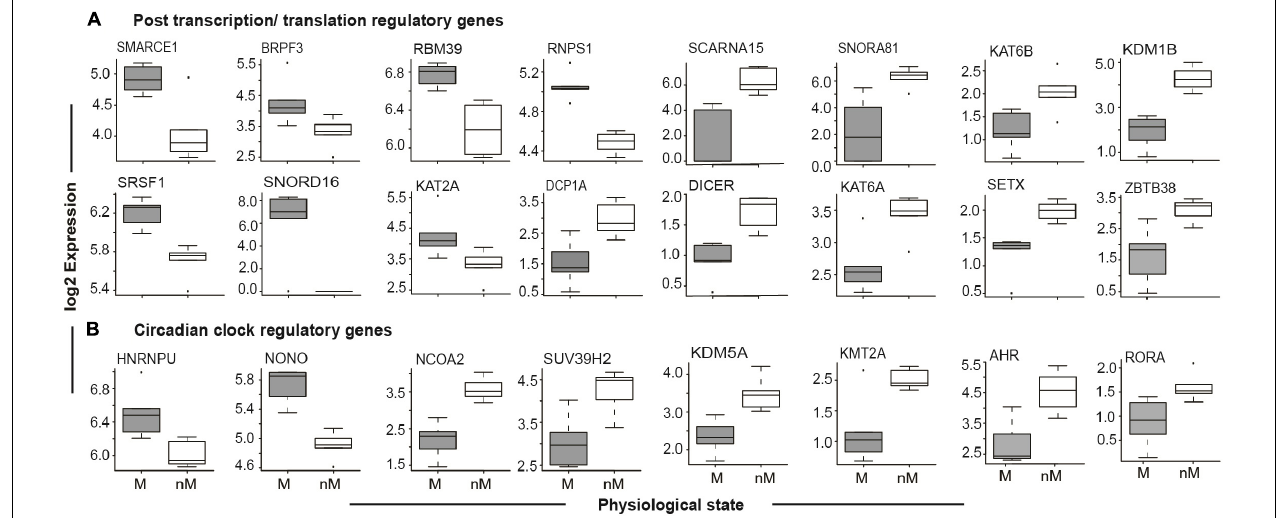
FIGURE 4 | Seasonal state-specific differences in gene expressions. Boxplot of log 2 FPKM expression values in 5–95% intervals of post transcription/translation regulatory genes (top panel, A ) and circadian clock regulatory genes (bottom panel, B ). The outliers are shown as dot in each figure. Wilcox Rank sum test was used to test the significant difference between migratory (M) and non-migratory (nM) states. For significance, alpha was set at 0.05.